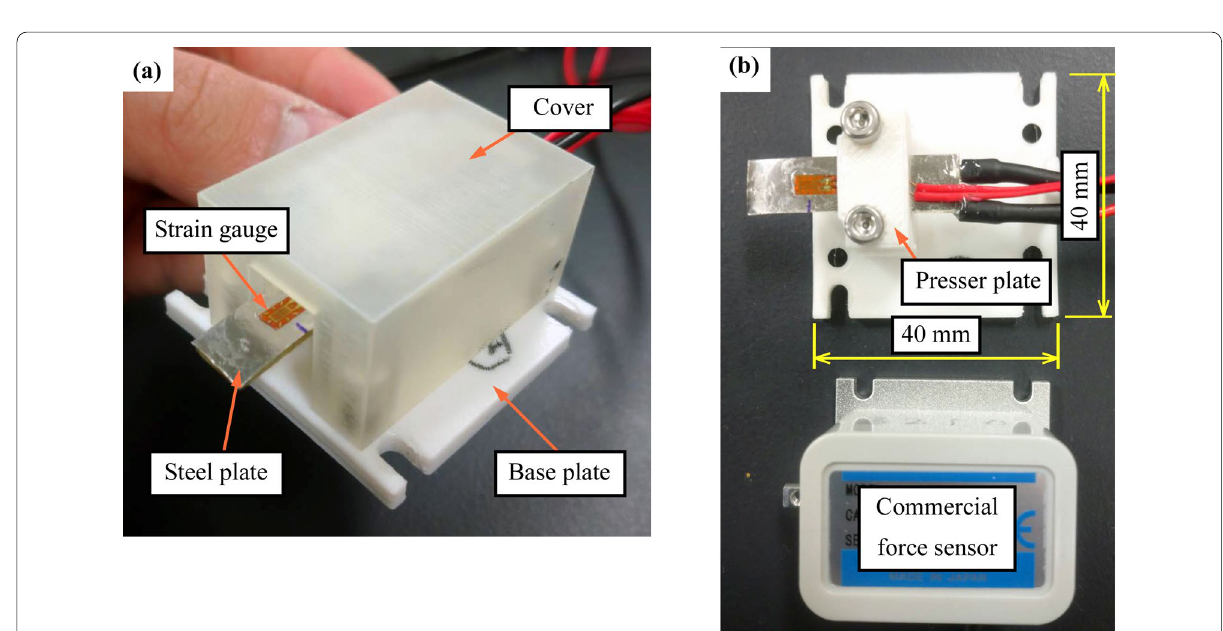
Fig. 6 Prototype force sensor using SMP. a External appearance. b Internal components